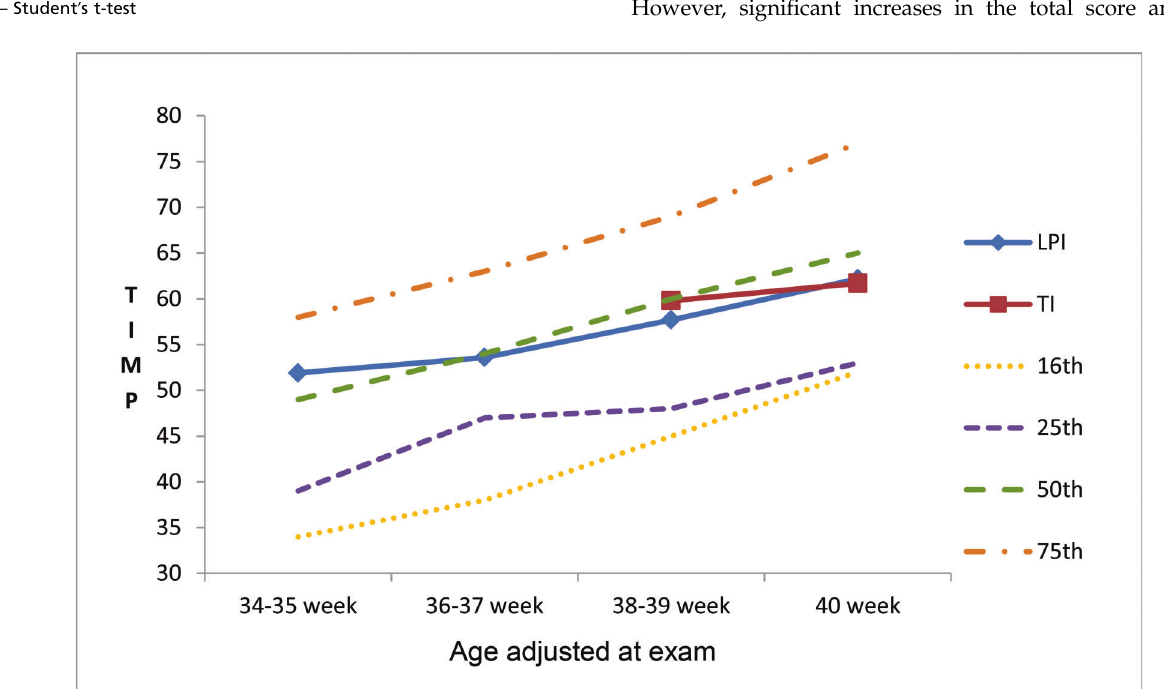
Figure 1 - Progression of total Test of Infant Motor Performance (TIMP) score in percentile, according to the corrected gestational age of late preterm newborn infants (LPI) and term infants(TI) at birth. Source: Adapted from TIMP Percentile Rank Standards 2004